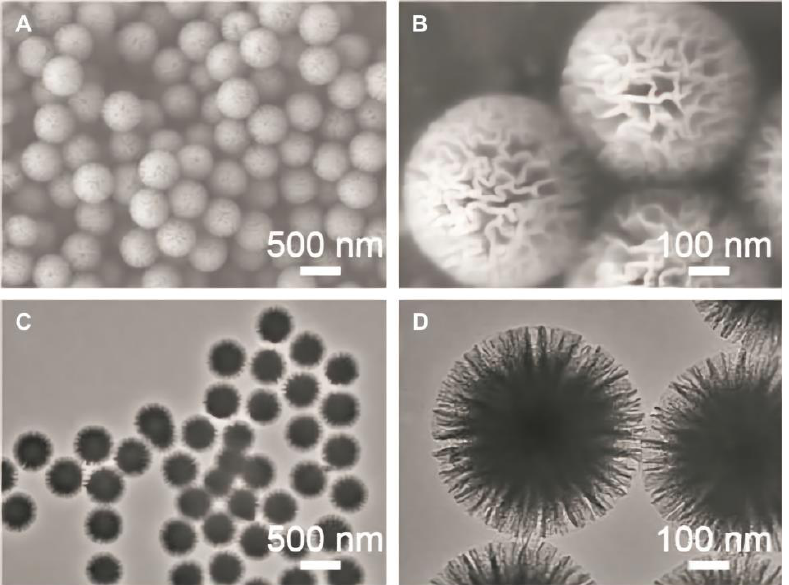
Figure 7. ( A , B ) Field emission scanning electron microscopy (FE-SEM) micrographs of wrinkled mesoporous silica and ( C , D ) TEM images of different magnifications of wrinkled mesoporous sil- ica.Images from